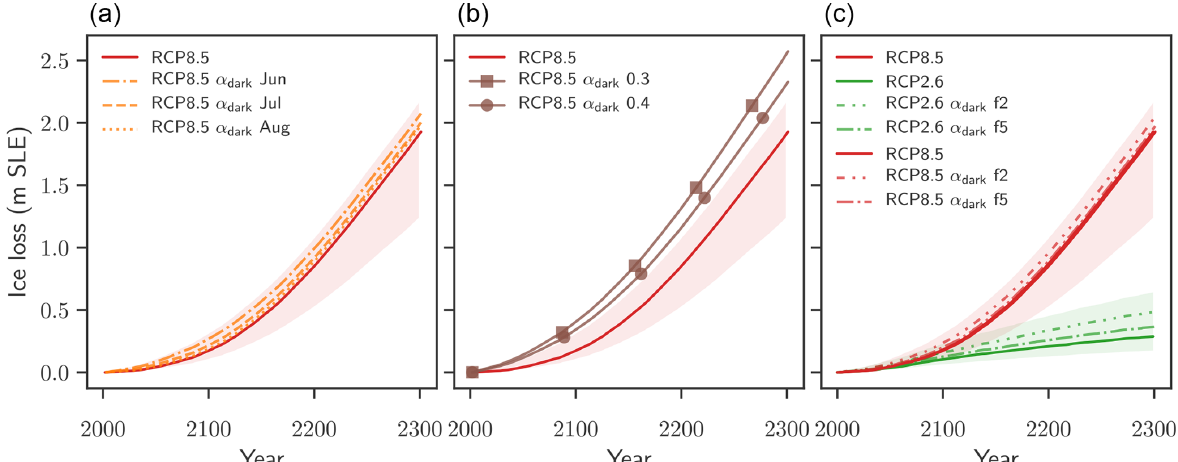
Figure B1. Sensitivity to the darkening scenario. Ice volume evolution for different implementations of the darkening scenario. The envelopes of minimal and maximal mass loss, given by the α 1990 and α dark experiments, and the RCP simulations with standard parameters are shown for reference. (a) Periods of extreme darkening in the α dark scenario are shortened to 1 month (orange broken lines). (b) The albedo value for extreme summer darkening is lowered to 0.3 (brown line with square markers) or 0.4 (brown line with circle markers). (c) Reducing the frequency of extreme darkening summers to every 2 (f2) and every 5 years (f5). Ice loss is given in metres of sea level equivalent. A value of 1ms.l.e. corresponds to approx. 361800Gt of